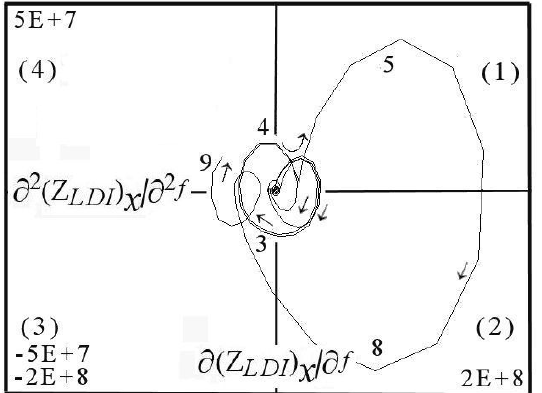
Figure 13. Phase-space derivative at medium frequency in diverging open-loop (events 3-4-5-9) for region of peak